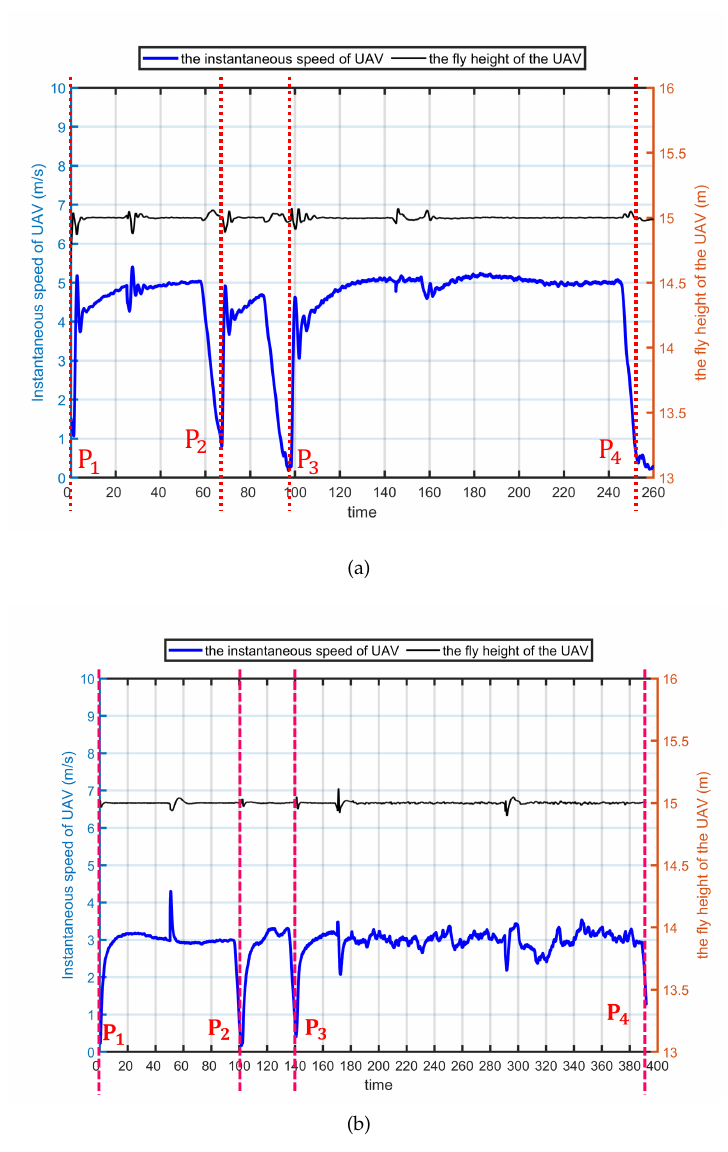
Figure 13. Presentation of the movements for UAV when it fly at 15 m with 3 ms − 1 and 5 ms − 1 in ground station. ( a ) The movements for UAV flying at 15 m, and its speed is 5 ms − 1 in ground control station. ( b ) The movements for UAV flying at 15 m, and its speed is 3 ms − 1 in ground control